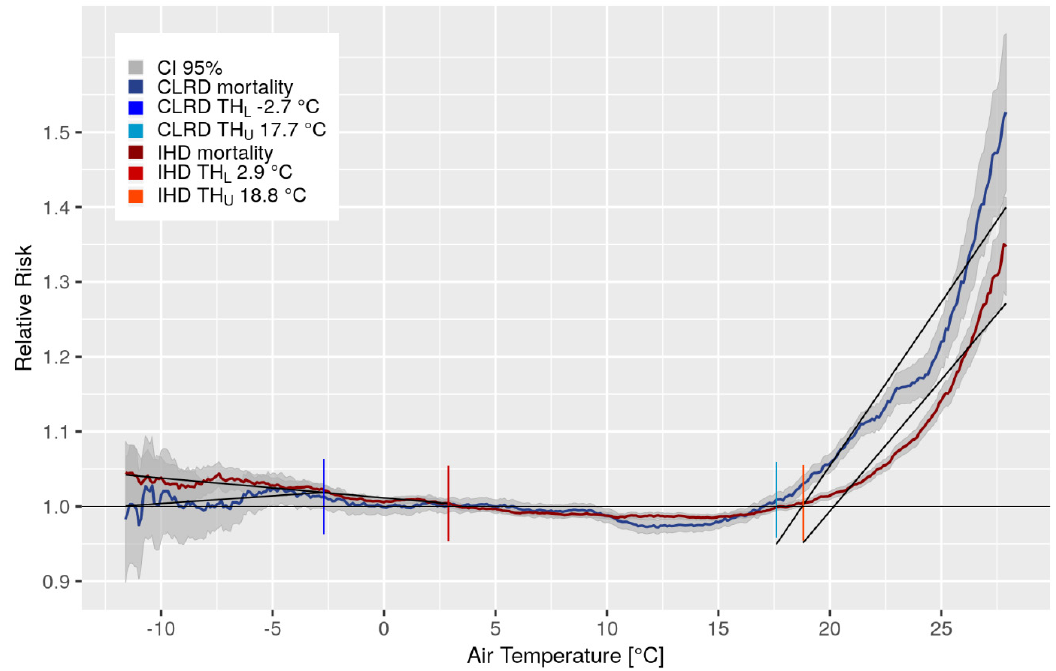
Figure 4. Relationship between T a and Relative Risk (RR) of CLRD and IHD mortality in the years 2001–2015 in Germany.